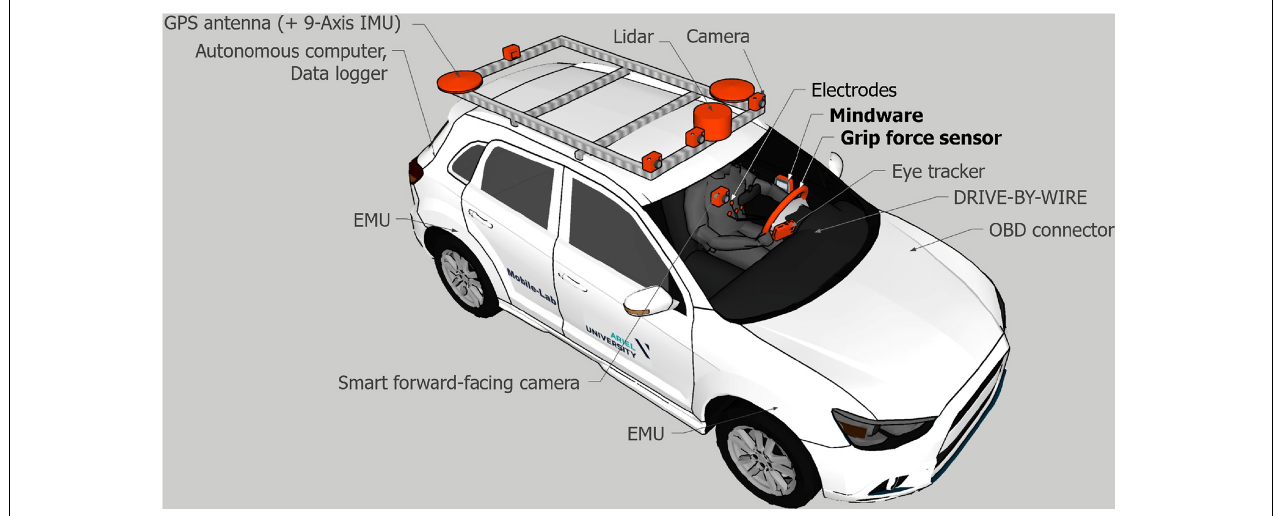
FIGURE 1 | The Mobile Lab, equipped with GPS and sensors, Mindware and grip force sensors, as well as additional equipment that was not used in the current research.